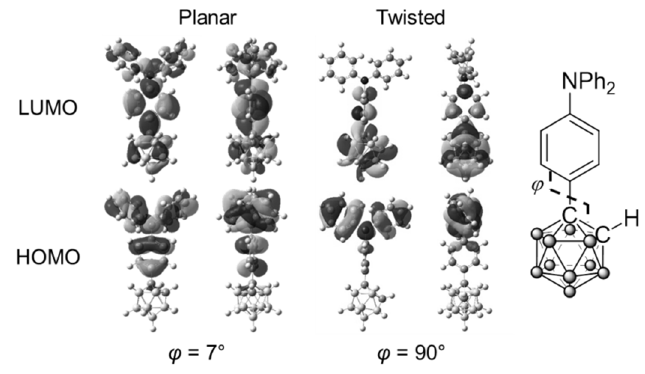
Figure 6. Calculated molecular orbitals in the transitions of 1B in the excited state.